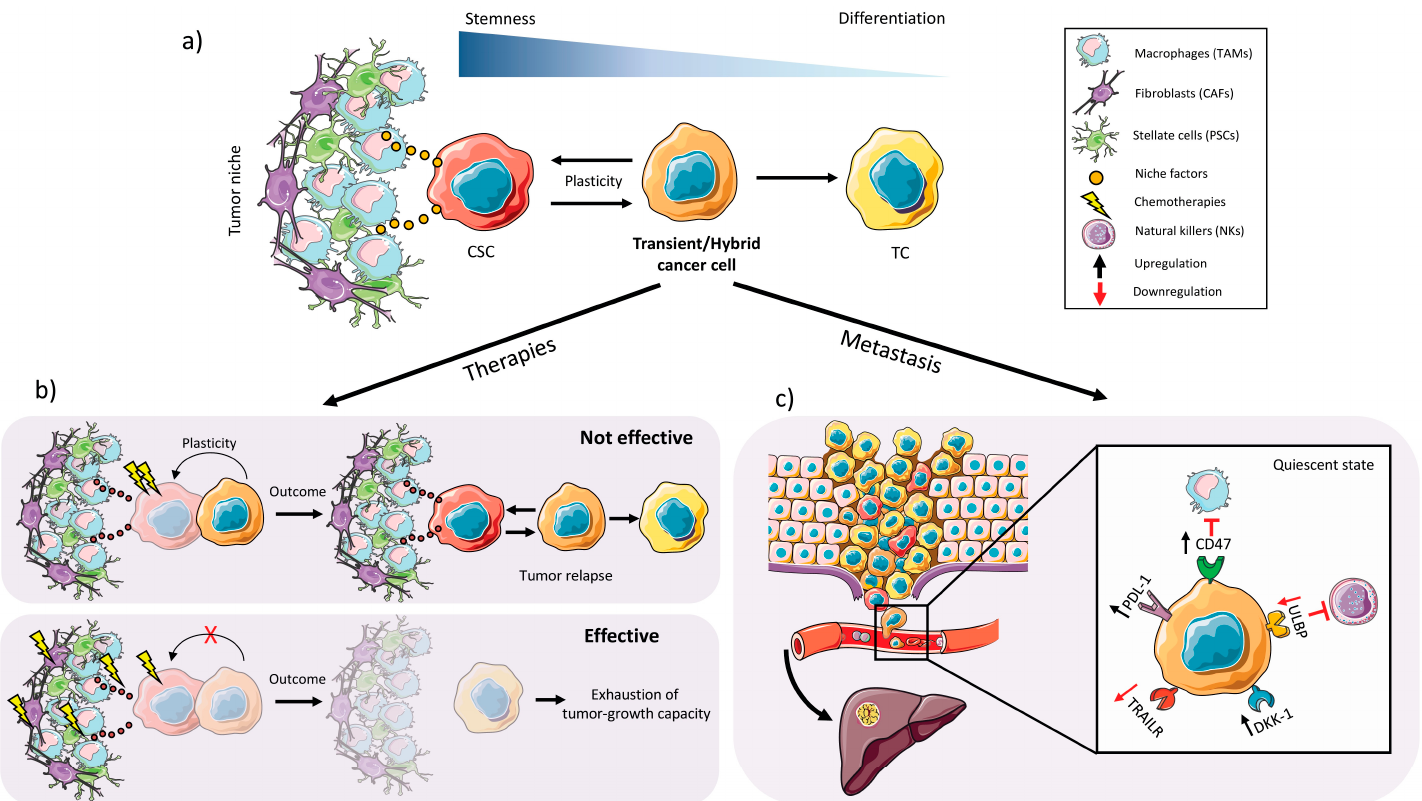
Figure 4. Redefining the roles of pancreatic cancer cells. ( a ) Inside the PDAC tumor we can find different types of tumor cells (TC), which have different states of differentiation and stemness: CSCs receive stimuli from the tumor niche that can influence the biology and overall status of the tumor as a whole and help CSCs maintain their stemness. In turn, CSCs can enter into an intermediate state of differentiation in which they maintain some of their stem capacity and express typical markers of differentiated TCs (hybrid/transient cancer cells). ( b ) Transient/hybrid cancer cells are able to survive under certain conditions and to regenerate tumor heterogeneity under therapeutic insult. For this reason, if combination therapies with anti-CSC/anti-tumor niche/anti-transient cell efficacy are used, it would be possible to eradicate the tumor in a more effective way. ( c ) Moreover, transient cancer cells are able to survive in the bloodstream and metastasize (e.g., to the liver) due to upregulation of CSC metastasis receptors such as CXCR4 and immune evasion receptors (PDL-1, CD47, DKK-1) and downregulation of death receptors (TRAILR and ULBP) and enter into a quiescent and immune evasion state.